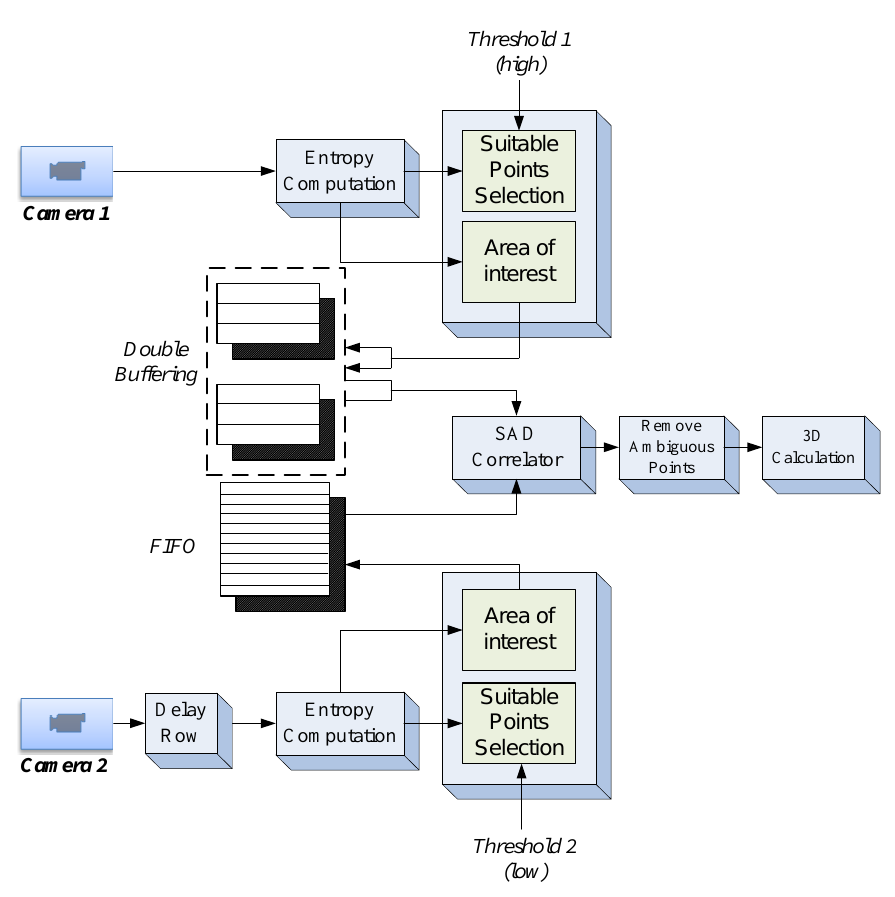
Figure 3. Proposed SoC